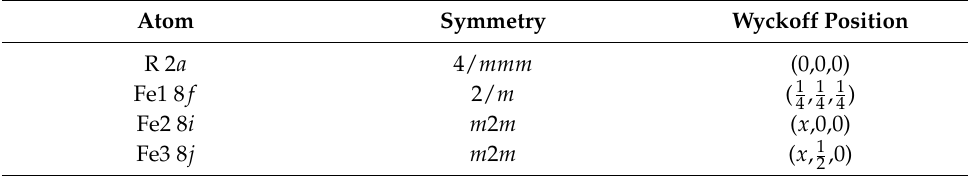
Table 4. Atom and Wyckoff positions for the R Fe 11 Ti I 4/ mmm tetragonal structure. Atom